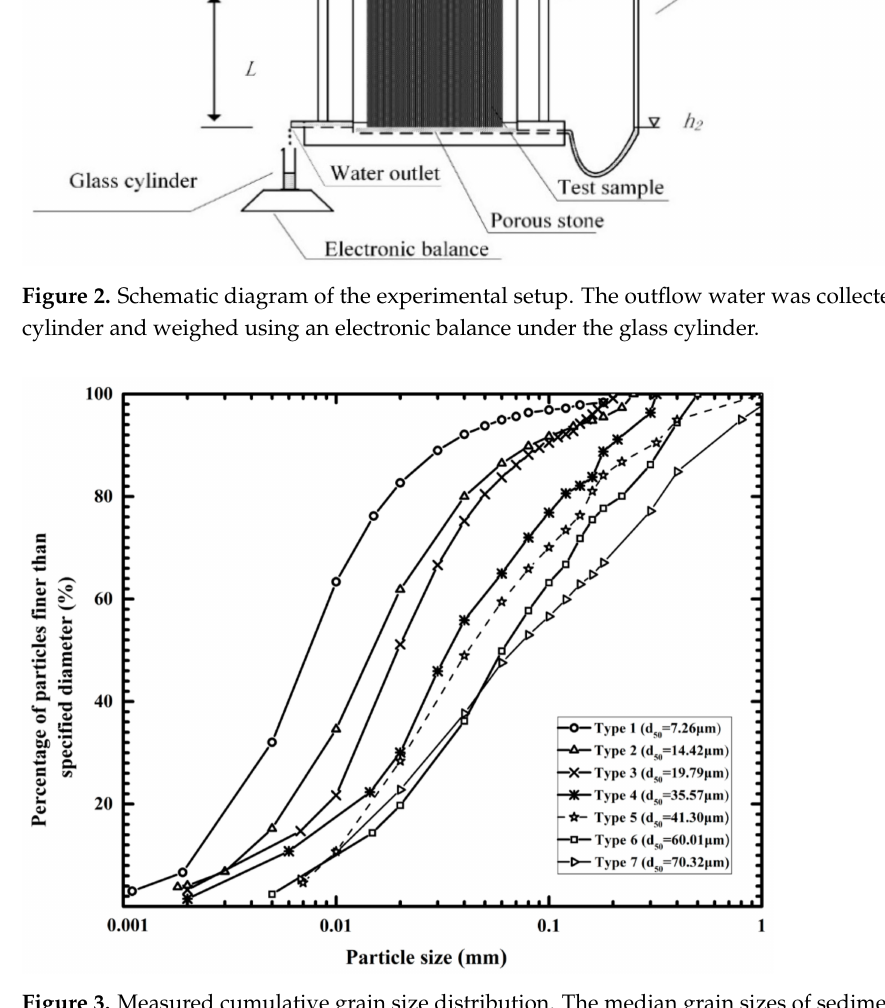
Figure 3. Measured cumulative grain size distribution. The median grain sizes of sediment types 1–7 varied between 7.26 µ m and 70.32 µ